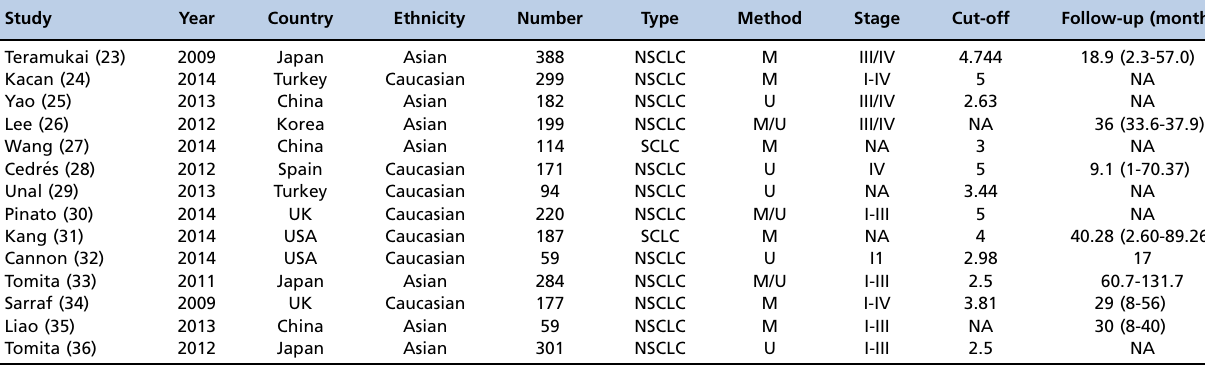
Table 1 - Characteristics of all included studies.